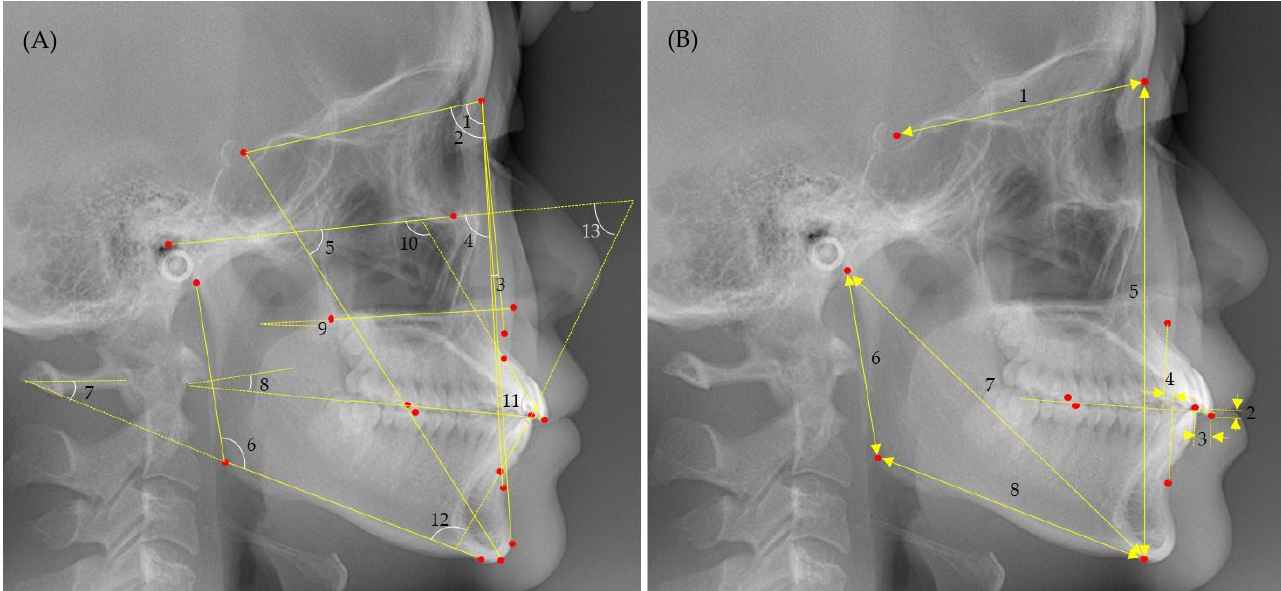
Figure 1. Angular ( A ) and linear ( B ) measurement items for lateral cephalometric analyses. ( A ) 1 —